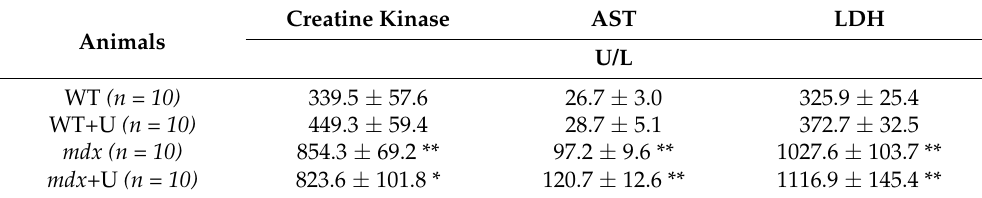
Table 1. The level of creatine kinase, AST, and LDH in the serum of experimental groups of mice. Creatine Kinase Animals